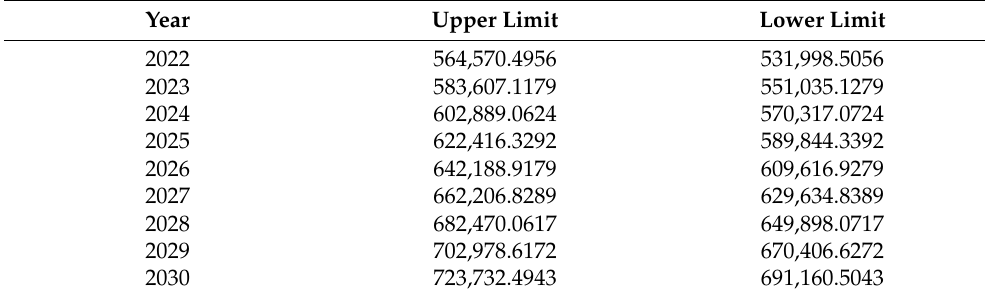
Table 7. Forecast range of total energy consumption in China from 2022 to 2030 (million tons of standard